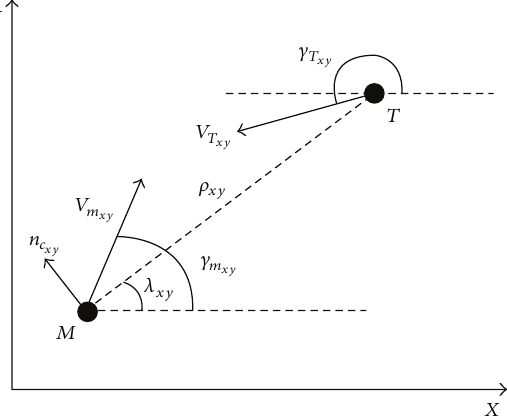
Figure 5: Relative kinematics on 𝑆 𝑥𝑦 plane.